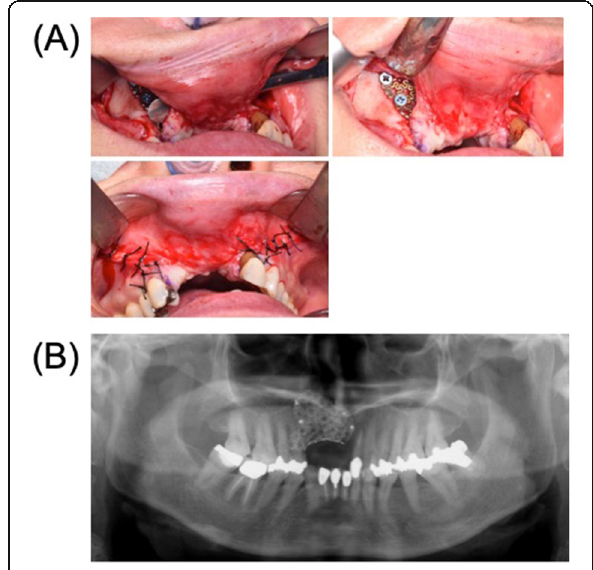
Fig. 4 Reconstruction with a custom-made titanium mesh by tunneling flap technique. a Intraoperative oral photograph.